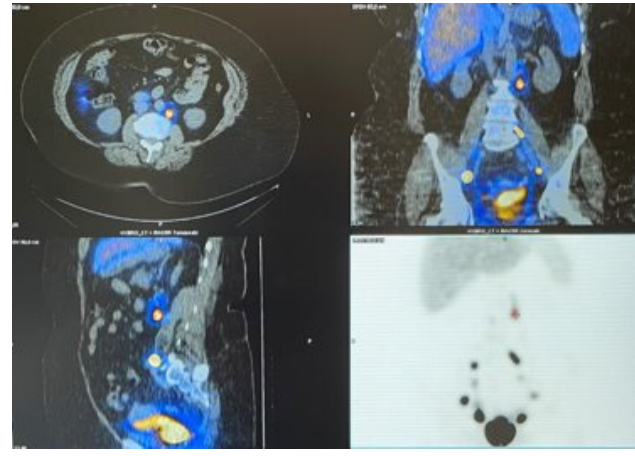
Figure 1. SPECT/CT with pelvic and para-aortic mapping.